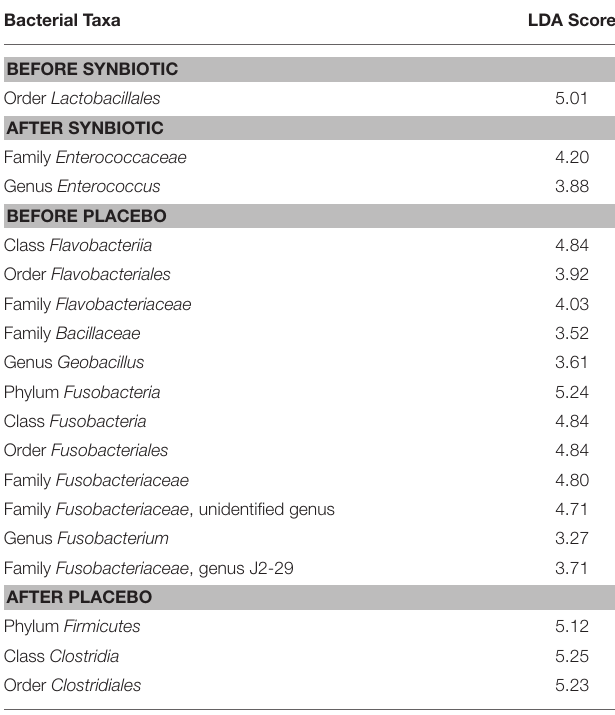
TABLE 1 | Linear Discriminant Analysis (LDA) of bacterial taxa from canine fecal samples and their associations with synbiotic treatment. Bacterial